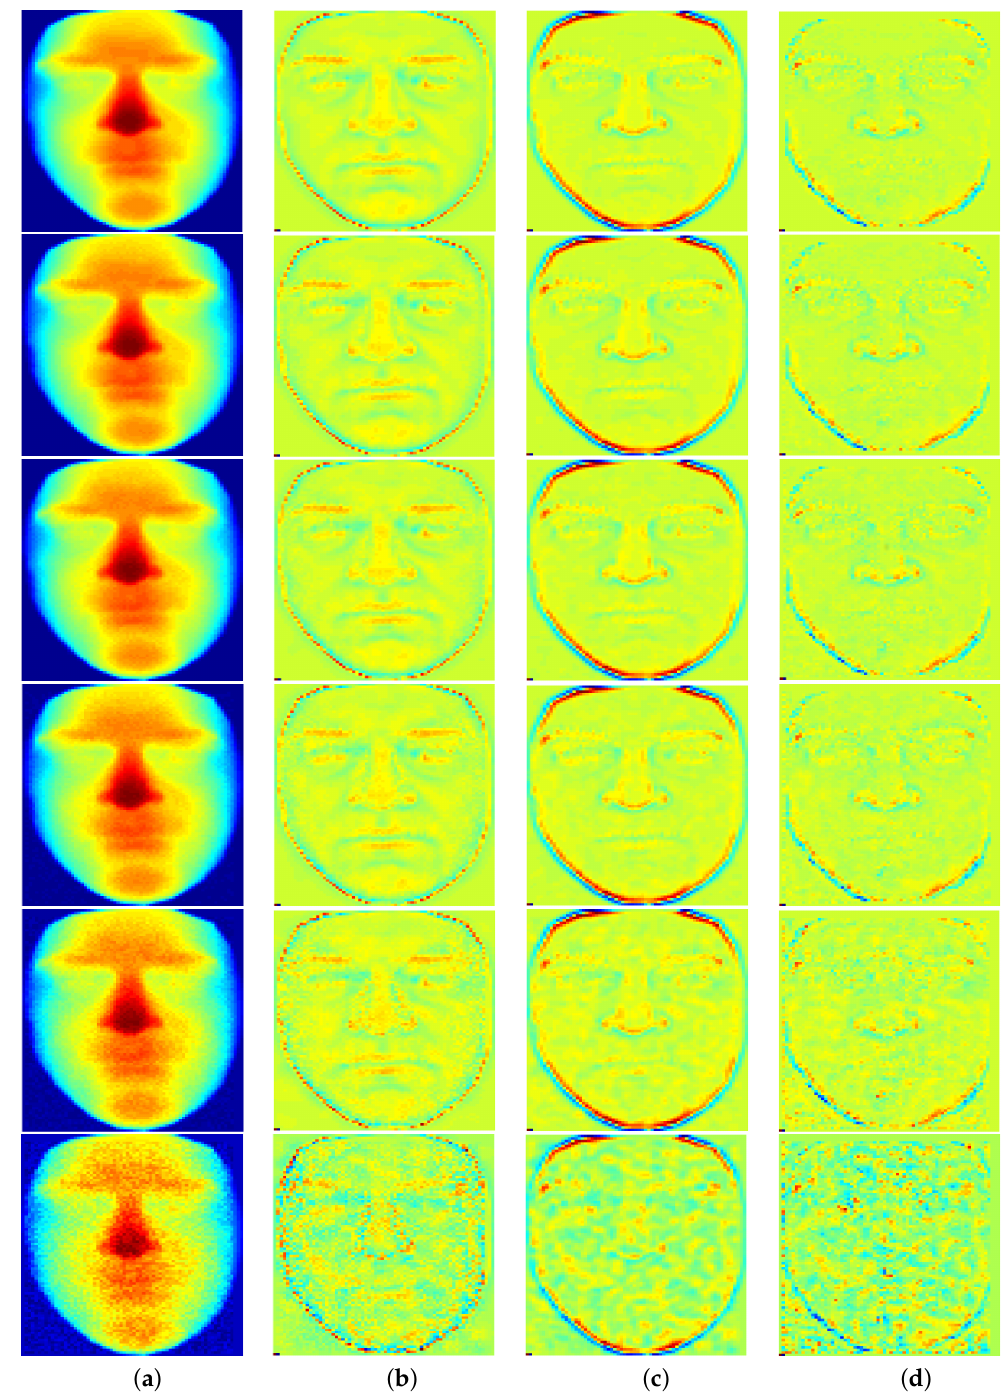
Figure 15. The differences of the results of the tested methods. Column ( a ) illustrates the applied noise, while columns ( b – d ) show the difference between the noisy model and the model filtered by the Bilateral and Gaussian filters and our filter, respectively. The noise is a random number in the interval [ − ασ , ασ ] , where σ is the standard deviation of the target model. The alpha values per row are 0, 0.5, 0.7, 1.0, 2.0 and